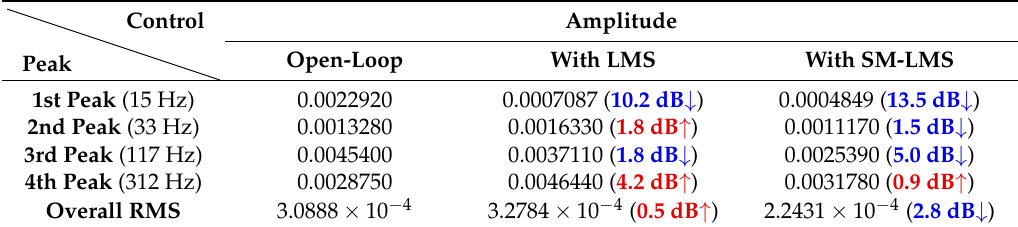
Table 5. Vibrational amplitudes of each case for the original beam